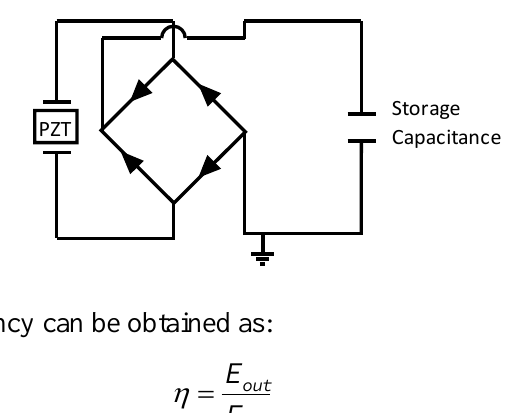
Figure 13. Schematic diagram for the energy storing